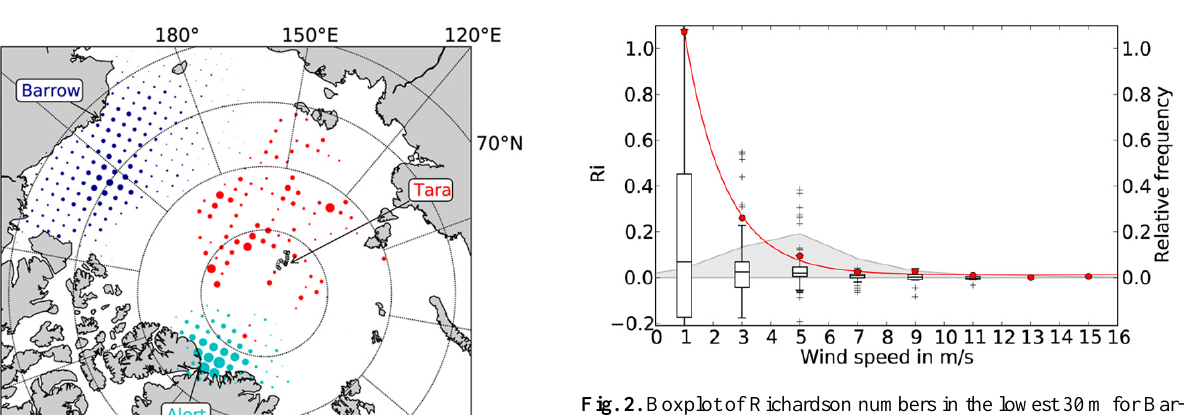
Fig. 2. Boxplot of Richardson numbers in the lowest 30m for Bar- row derived from radiosonde data in wind speed bins of 2ms − 1 (box: quartiles; whiskers: 1.5 times the inner quartile range). The red line is a polynomial fit to the 90% quantiles, and the gray shaded area is the frequency distribution of wind